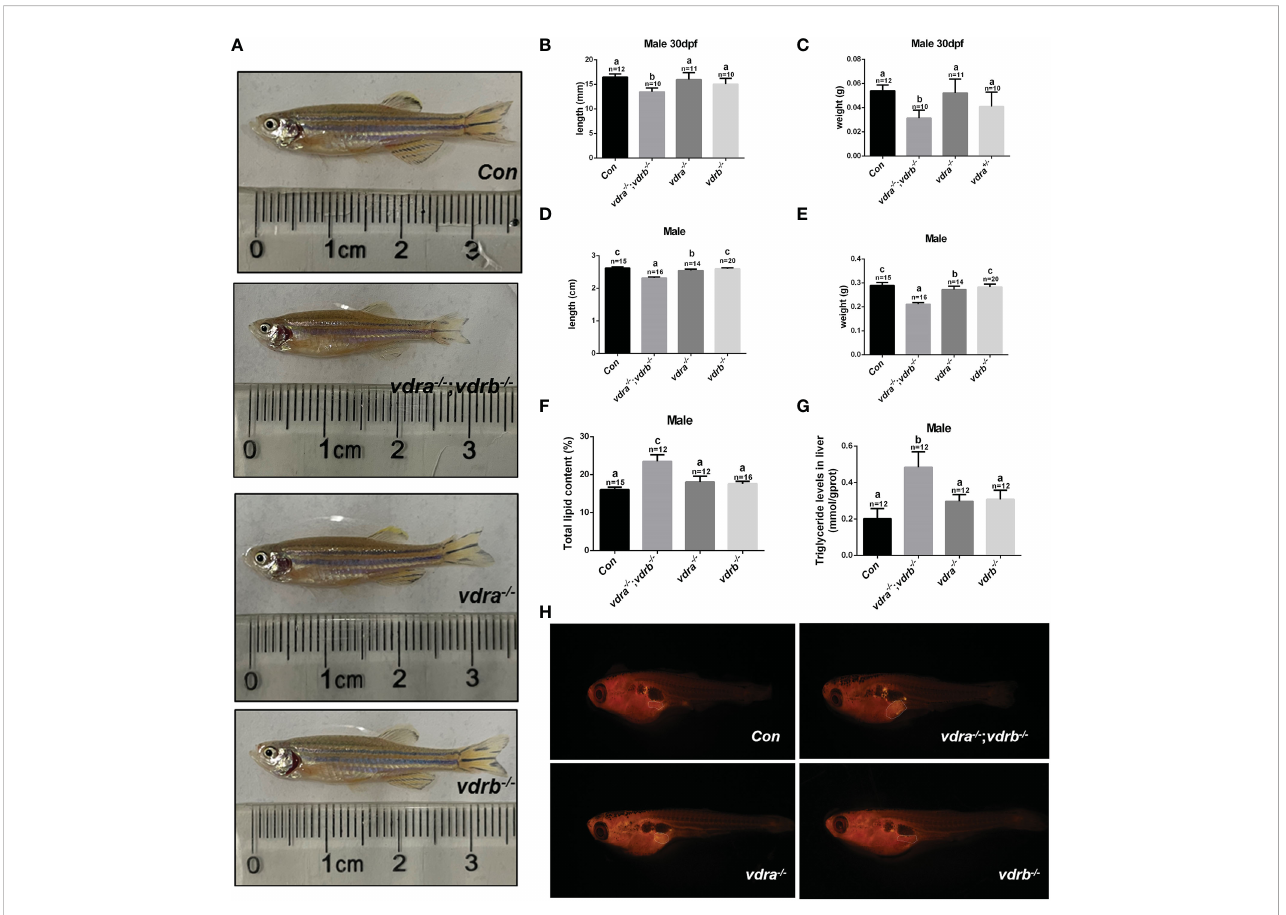
FIGURE 3 Retarded growth and accumulated adiposity observed in vdra -/- ; vdrb -/- zebra fi sh. (A) Comparison of the morphological features of mutants and control siblings at 100 dpf; (B – E) The body length and weight of the mutant lines and control siblings. (B, C) showed the zebra fi sh at 30dpf and (D, E) showed the zebra fi sh at 100dpf. (F) The total lipid levels of male mutants and controls at 100 dpf; controls, n = 15; vdra -/- ;vdrb -/- , n = 12; vdra -/- ; vdrb +/- , n = 12; vdra +/- ; vdrb -/- , n = 16; (G) The levels of triglycerides in the liver of mutants and control siblings at 100 dpf; (H) . Neutral lipids of juvenile mutants and size-matched controls (both with a standard length of 7.6 mm) were stained with Nile Red and viewed with stereoscope. The visceral adipose tissue was labeled by the surrounded dashed line. The bars with different letters indicated signi fi cant difference